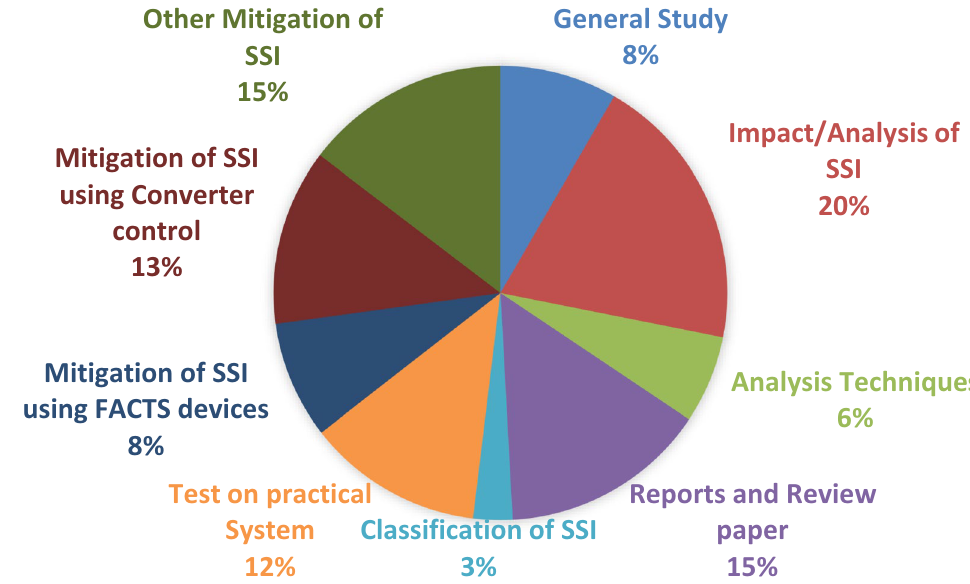
Fig. 15 Percentage of articles in WPP on SSI for each research